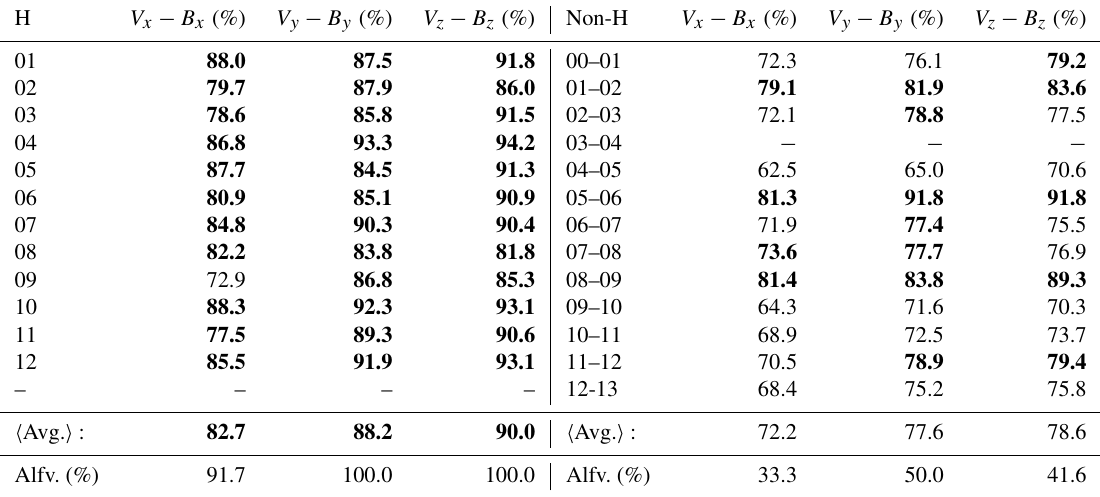
Table 1. HILDCAA events for the year 2003. The HILDCAA events with 4WPCC higher than the 4WPCC annual average are highlighted in bold.